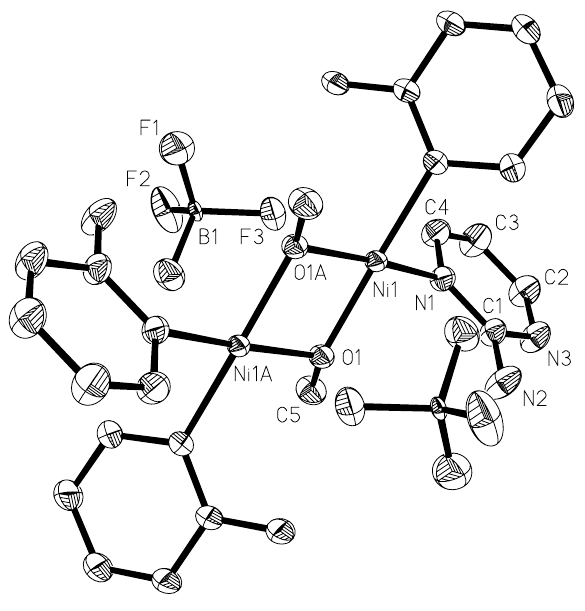
Table 1. Data collection and handling.